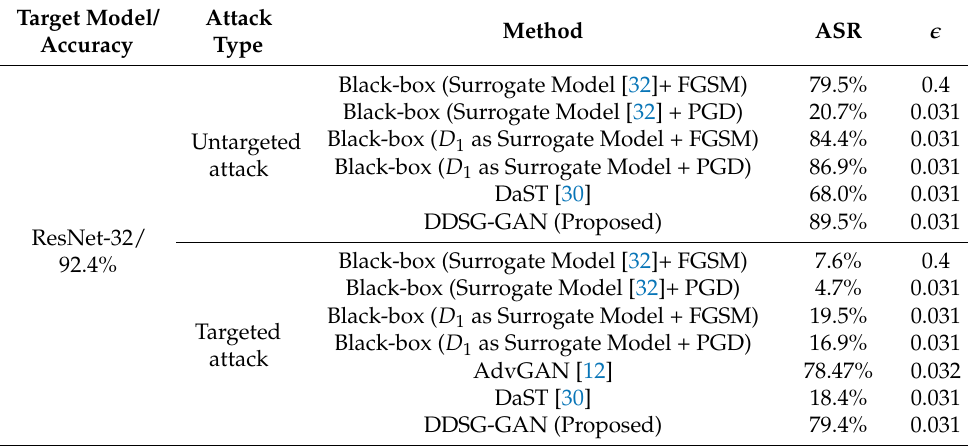
Table 7. Attack results under l ∞ norm on CIFAR10.